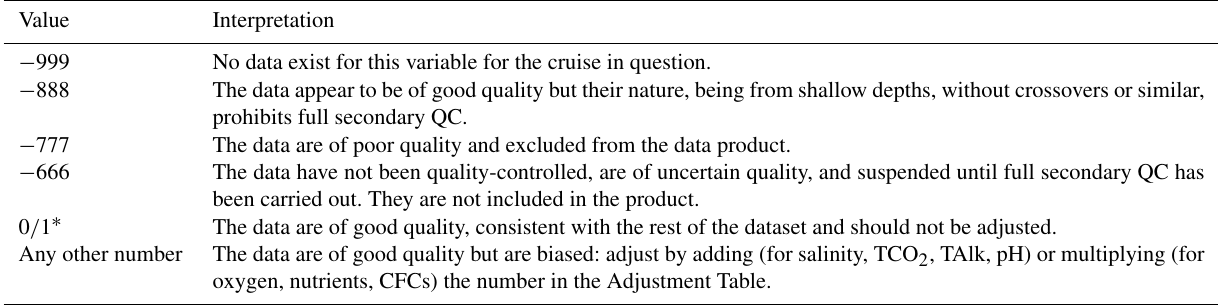
Figure 2. Summary figure used to evaluate TCO 2 crossover offsets of WOCE repeat section AR07W cruise 18HU19960512 in the Labrador Sea. The figure shows the 25 crossover offsets that were determined, sorted by time. 18HU19960512 is indicated by the blue line. Negative values mean that 18HU19960512 TCO 2 values are lower than those of the comparison cruise. Table 3. Possible values in the Adjustment Table and their